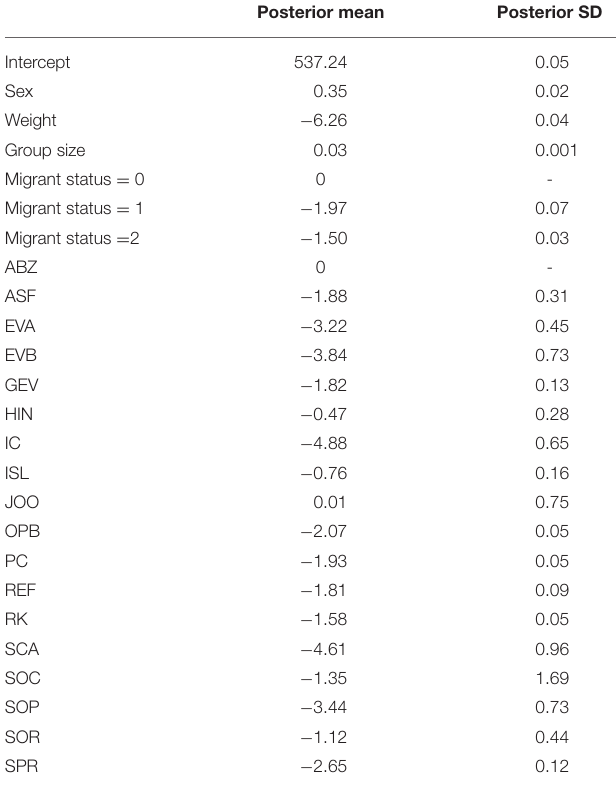
TABLE 3 | Regression coefficients for the full